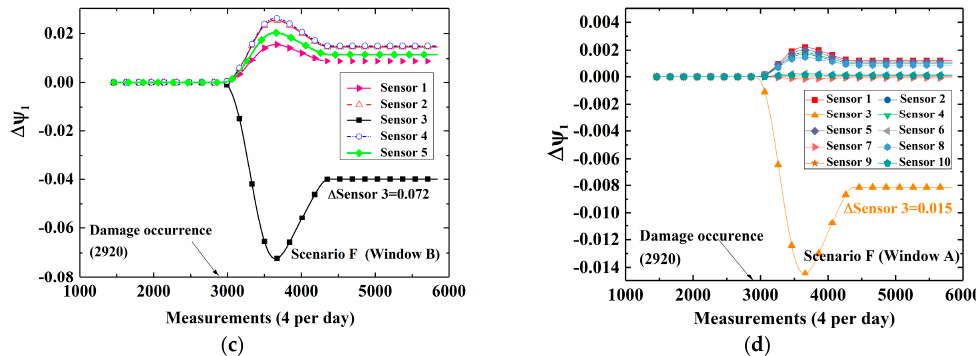
Figure 9. Cont. Figure 9. Cont.